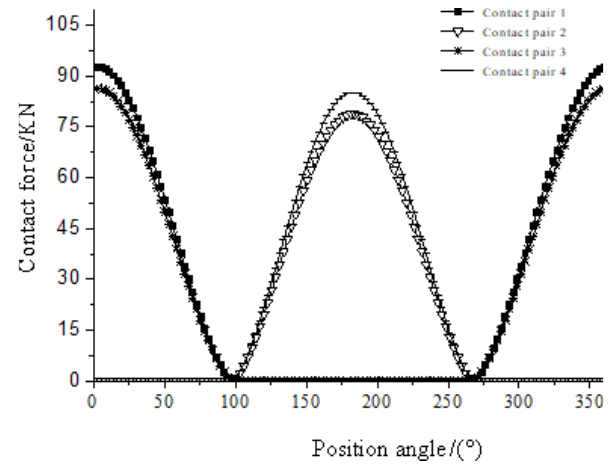
Figure 6: Contact force distribution in the bearing with rigid rings